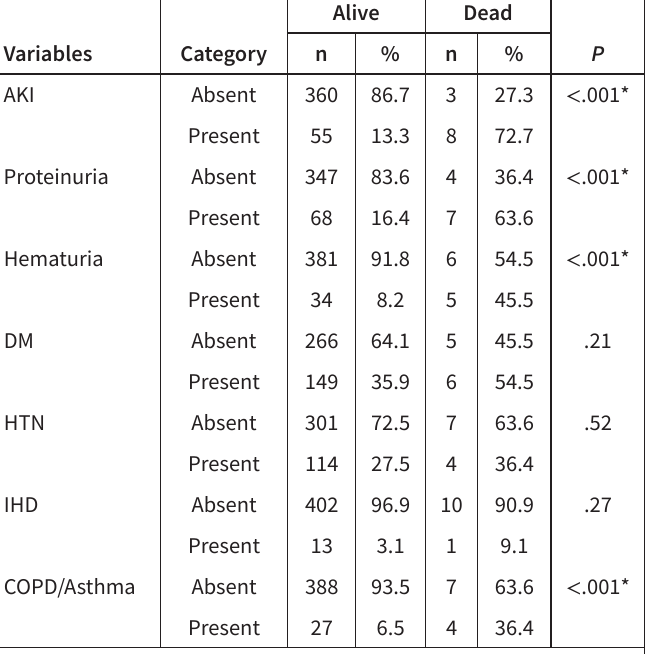
Table 9. Comparison of Mortality Rate with Presence of AKI, Proteinuria, Hematuria and Comorbidities Among Patients Using Chi-Square Test